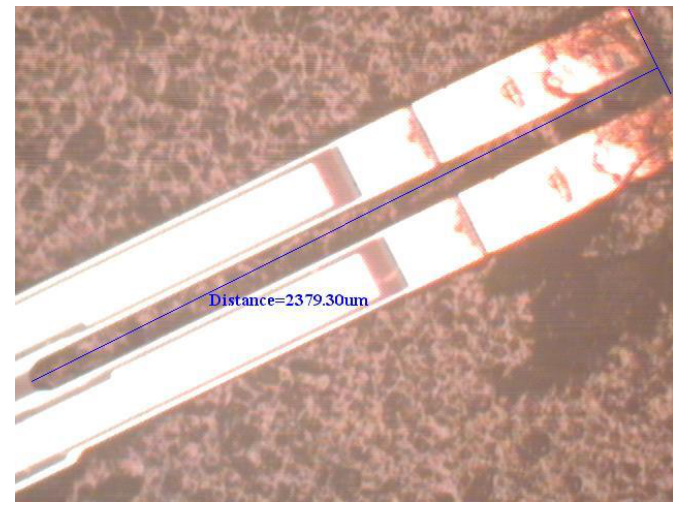
Figure 12. Determination of the length of the prong from a microscope image. Sensors 2019 , 19 , x